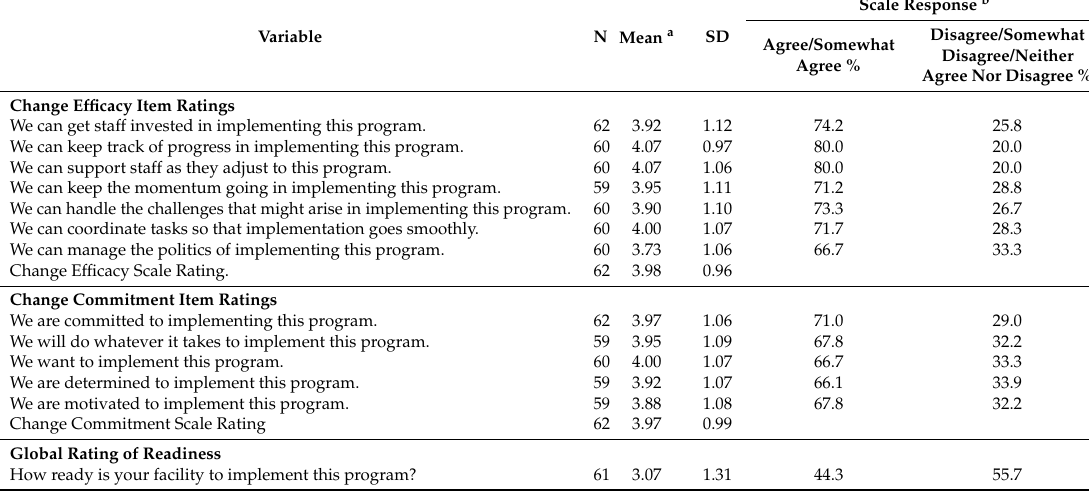
Table 3. Perceptions of dialysis facility organization-level change efficacy and change